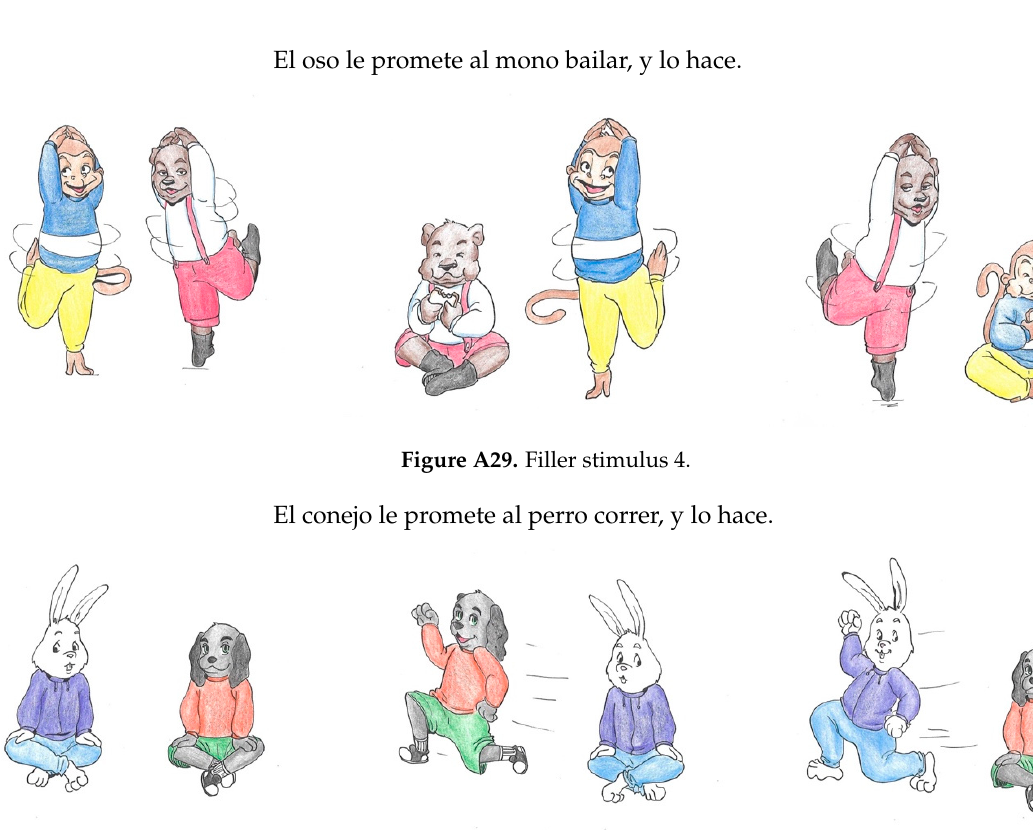
Figure A28. Filler stimulus 3.